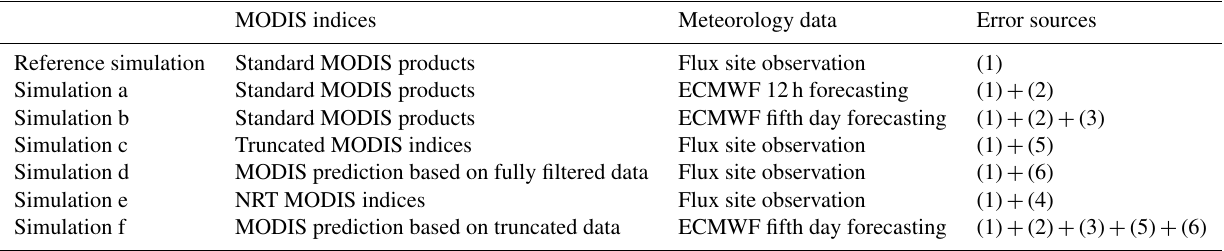
Table 2. The experiment setup and the error sources addressed in each simulation. The numbering in the last column corresponds to the error from (1) the VPRM model, (2) the meteorological analysis, (3) the meteorological forecast, (4) the MODIS NRT data, (5) data truncation and (6) the prediction of MODIS